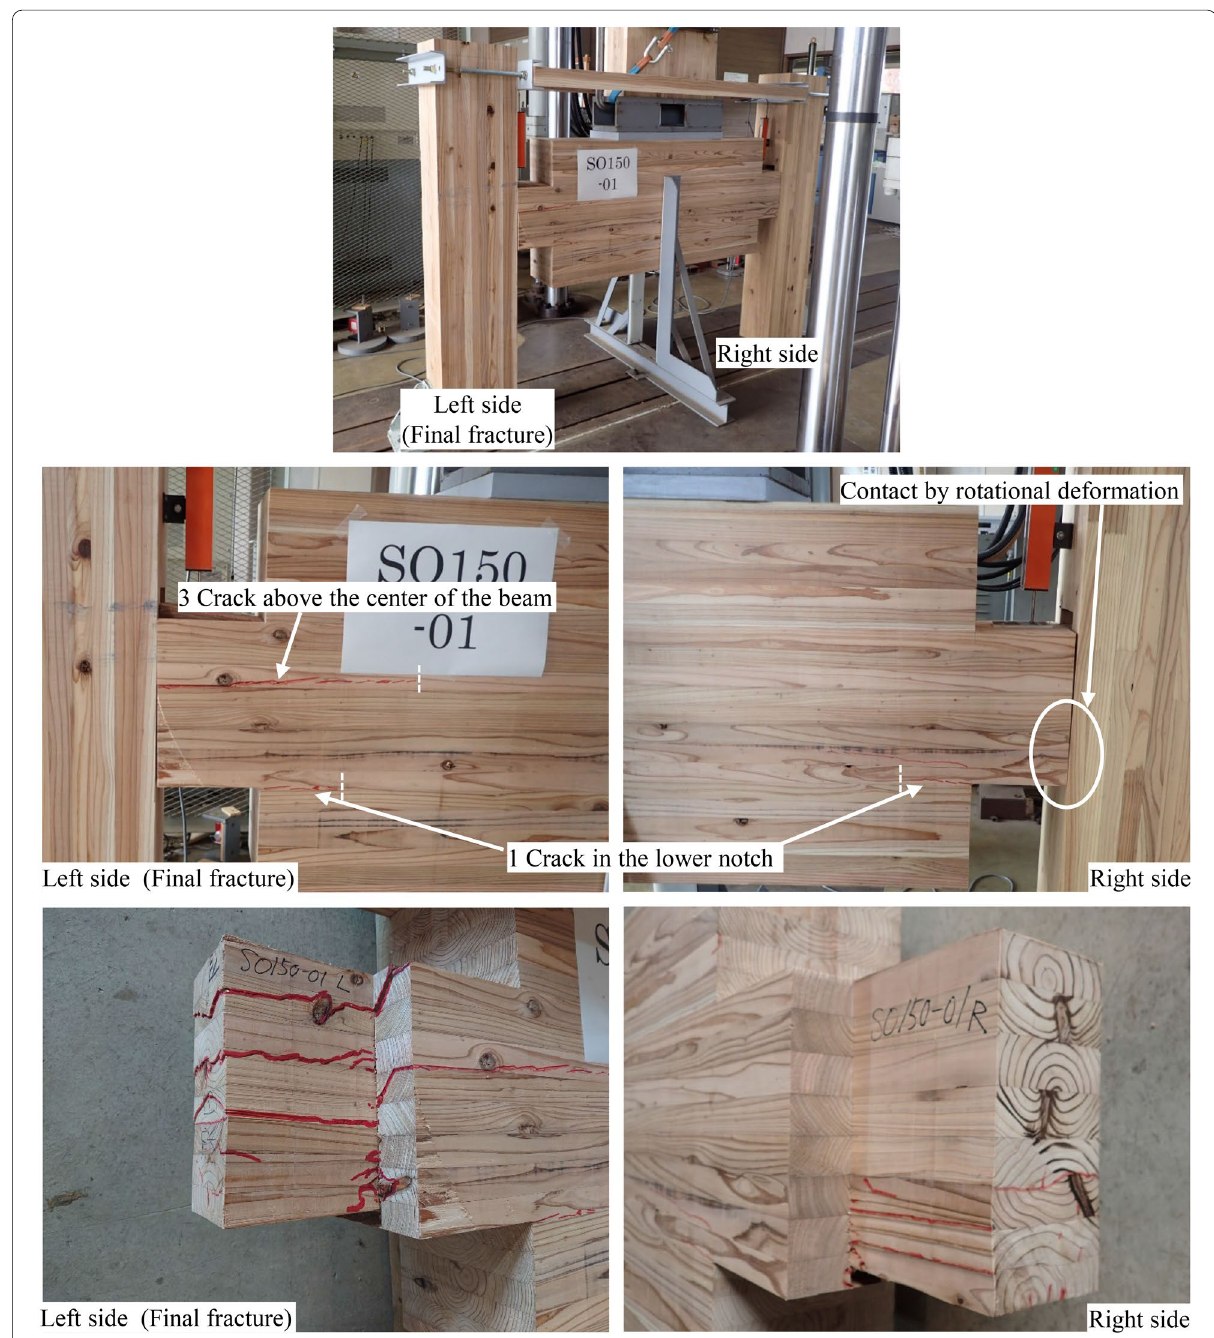
Fig. 13 Final fracture state of the specimen (J-L150, No.